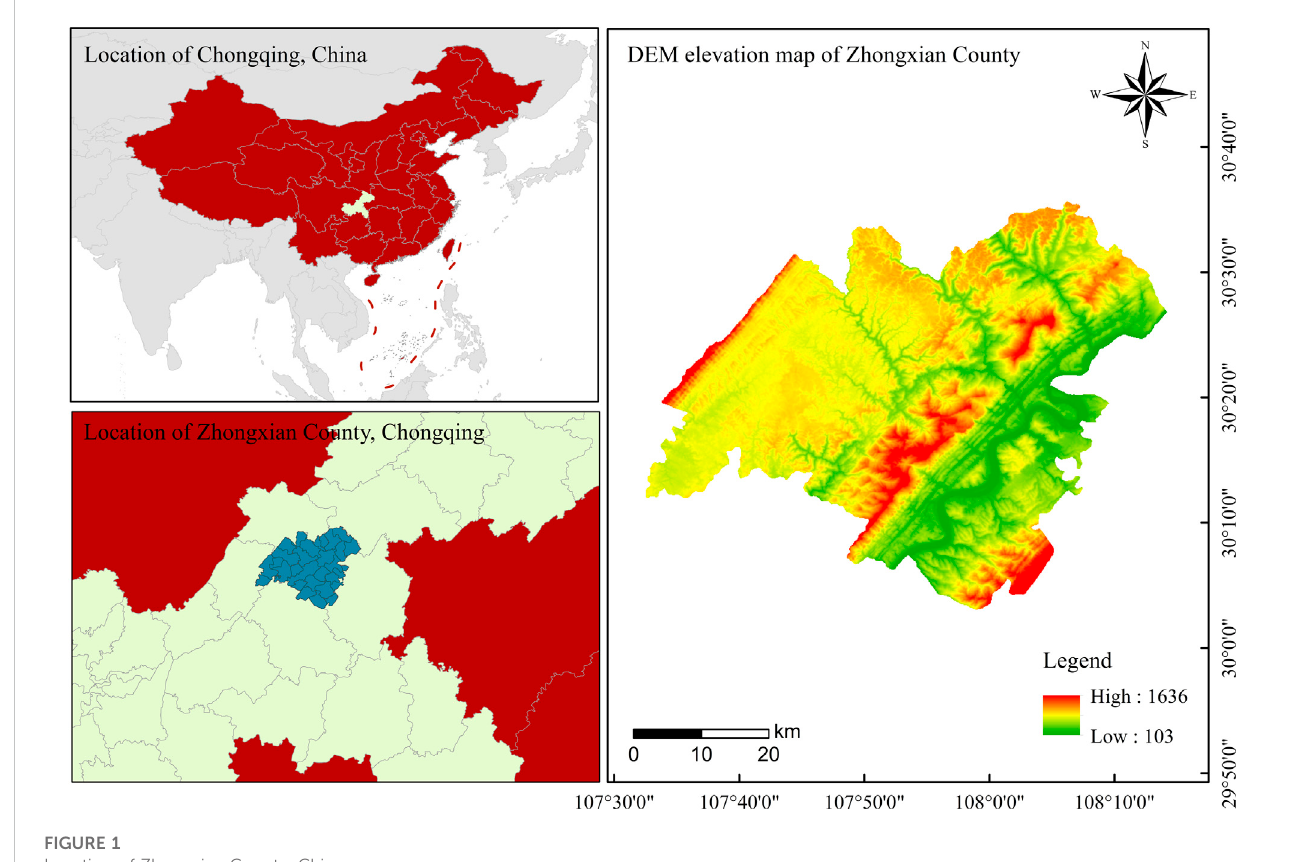
FIGURE 1 Location of Zhongxian County,